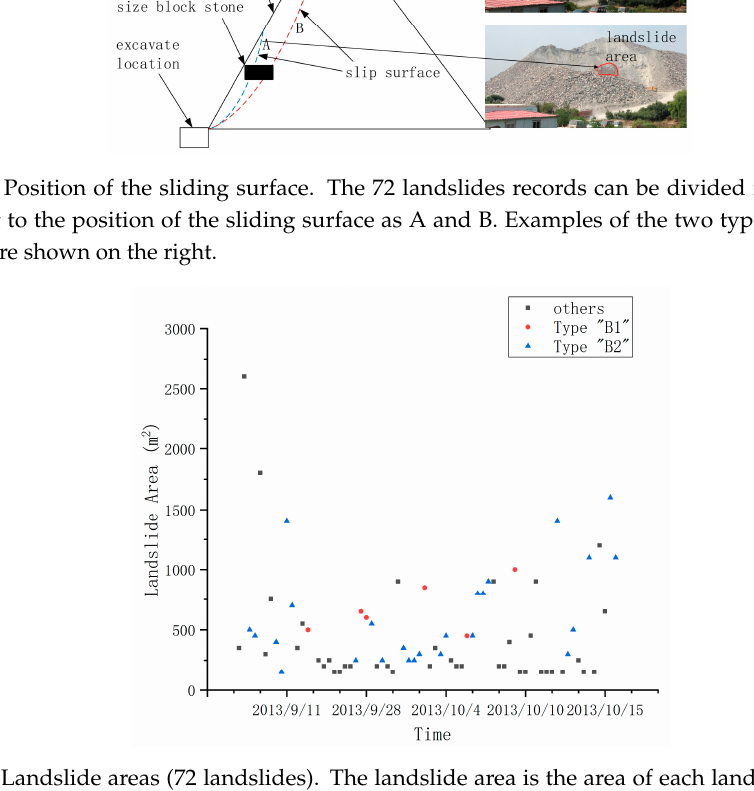
Figure 7. Landslide areas (72 landslides). The landslide area is the area of each landslide